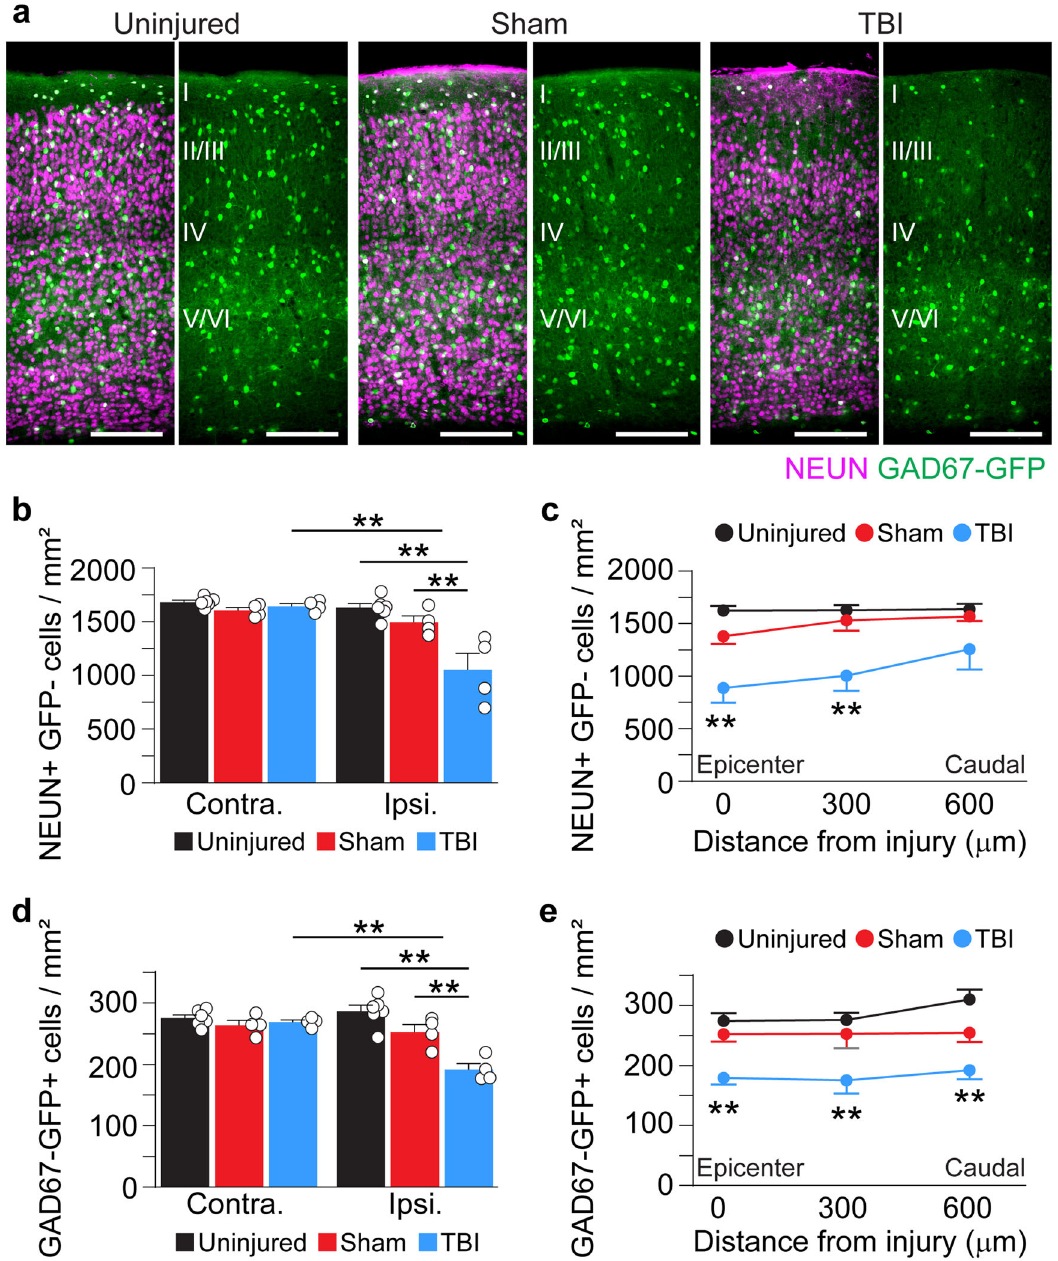
Fig. 2 Neuron loss in V1 0.5 months after TBI. a Coronal images of control, sham, and CCI-injured V1 labeled for NEUN (magenta) and GAD67-GFP (green). b Quanti fi cation of NEUN + /GFP- cell density in uninjured control, sham, and brain-injured mice 0.5 months after CCI. ** P = 1.79E-05, ipsilateral control versus ipsilateral TBI, ** P = 1.77E-03, ipsilateral sham versus ipsilateral TBI, ** P = 4.56E-05, ipsilateral TBI versus contralateral TBI; two-way ANOVA with Tukey ’ s post hoc test, N = 4 – 6 mice per group. c NEUN + /GFP- cell density at 0 – 600 µ m from the injury epicenter. ** P = 7.86E-05, control versus TBI (0 μ m), ** P = 1.01E-03, control versus TBI (300 μ m); two-way repeated-measures ANOVA with Tukey ’ s post hoc test; N = 4 – 6 mice per group. d Quanti fi cation of GAD67-GFP + cell density in uninjured control, sham, and brain-injured mice 0.5 months after CCI. ** P = 1.07E-06, ipsilateral control versus ipsilateral TBI, ** P = 1.58E-03, ipsilateral sham versus ipsilateral TBI, ** P = 9.25E-05, ipsilateral TBI versus contralateral TBI, two-way ANOVA with Tukey ’ s post hoc test, n = 4 – 6 per group. e GAD67-GFP + cell density at 0 – 600 µ m from the injury epicenter. ** P = 3.53E-03, control versus TBI (0 μ